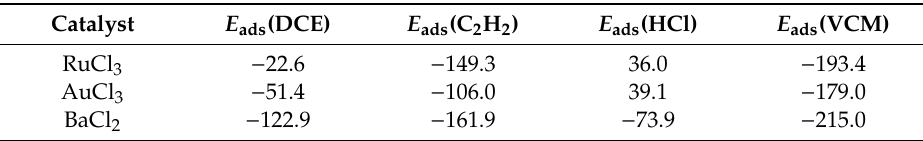
Table 1. Adsorption energies of DCE, C 2 H 2 , HCl, and vinyl chloride monomer (VCM) on the catalytic surfaces. Unit: kJ mol − 1 .